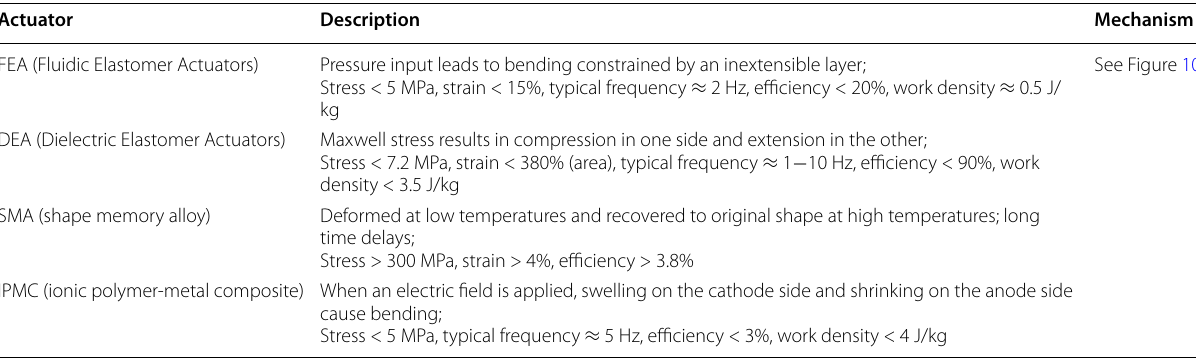
Note: (1) As a reference, the performance metric of mammalian muscle is listed here. Stress 40 J/kg. (2) The relevant data in Table 5 are gathered from Refs. [223, −